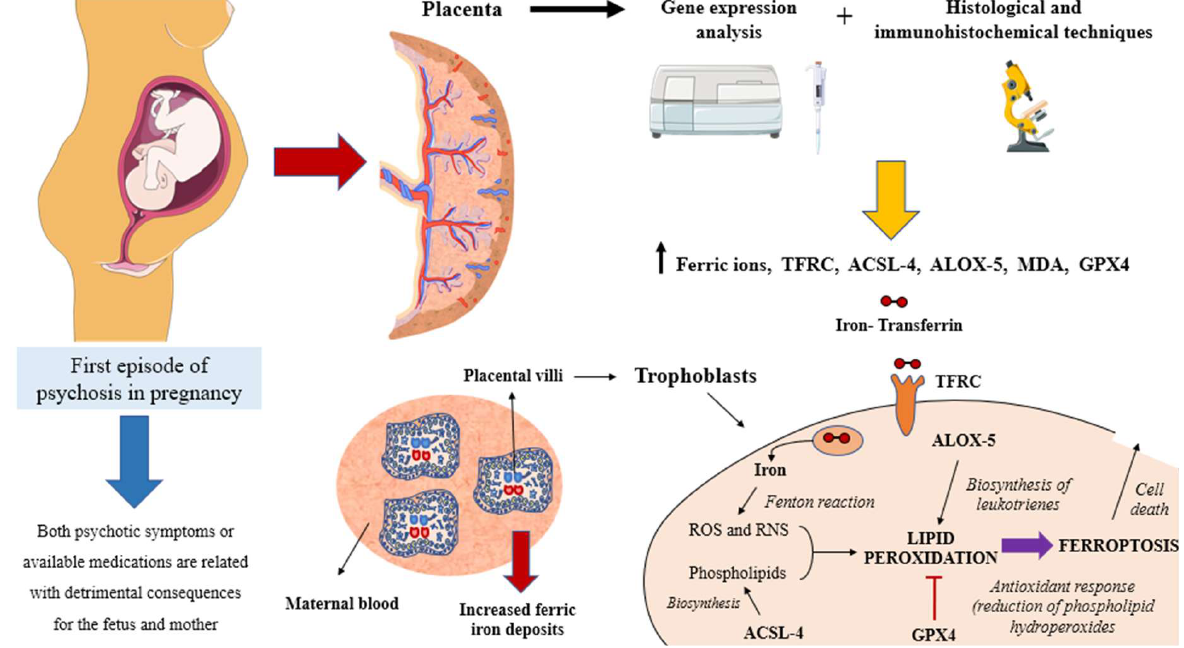
Figure 7. A global view of the main aspects and implications discussed in this work. As showed prior, a first episode of psychosis in pregnancy entails multiple challenges for healthcare professionals.